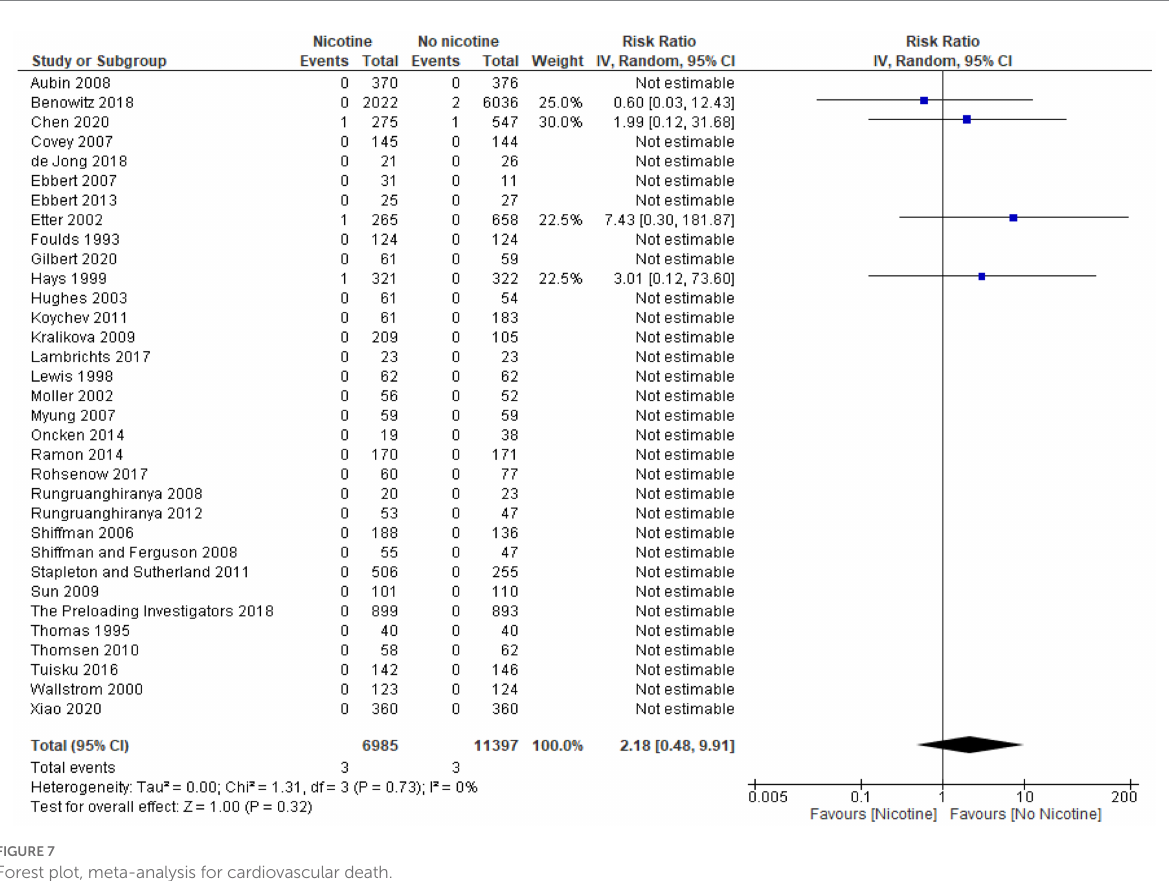
FIGURE 7 Forest plot, meta-analysis for cardiovascular death.